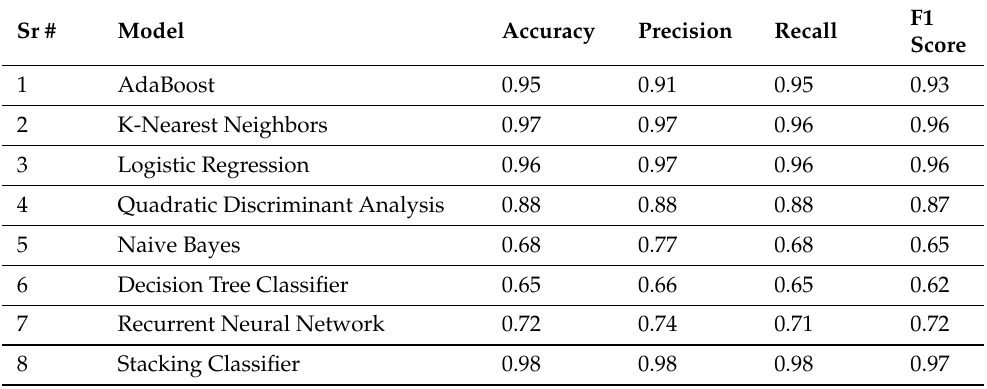
Table 2. Comparison of evaluation matrices to other